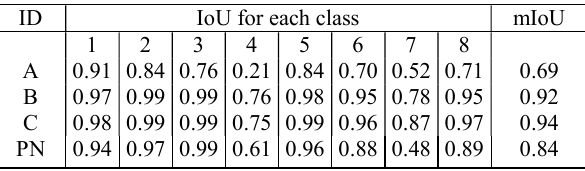
Table 6. Classification results of the test dataset for different combinations of features